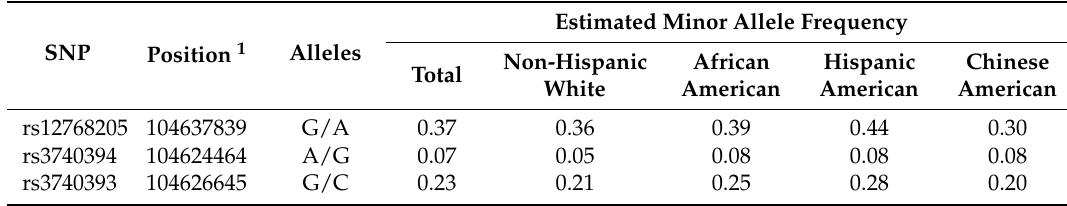
Table 3. Summary of candidate single nucleotide polymorphisms (SNPs).